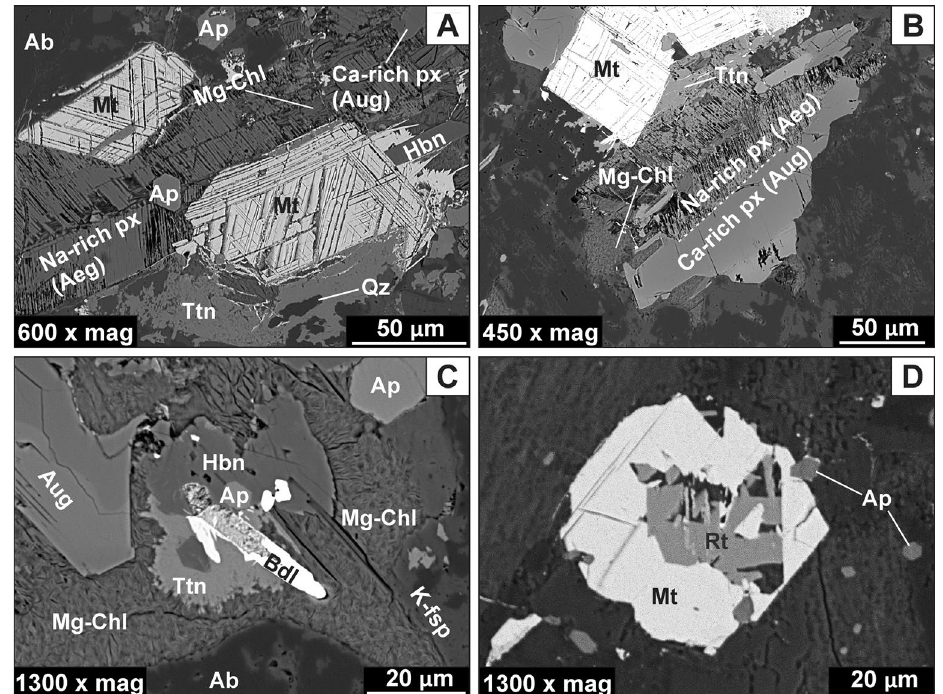
Figure 4. SEM-BSE images of Głuszyca trachyandesites collected from lower parts of the laccolith and showing the presence of unaltered mafic phases such as pyroxene-group species and Ti–rich magnetite. ( A ) Na-rich pyroxene (aegirine) accompanied by Ti–rich magnetite (Mt) consisting oriented thin (trellis-type) intergrowths of ilmenite lamellae. Note the presence of hornblende (Hbn), apatite (Ap), as well as secondary titanite (Ttn) and quartz (Qz); ( B ) Chloritized Na-rich pyroxene (aegirine) enveloped by relatively fresh Ca-rich pyroxene (augite); Note the sharp boundary between those phases, as well as the formation of etched cleavage planes within host Na-rich pyroxene. ( C ) Partial alteration of augite into fibrous Mg-rich chlorite (Mg-Chl); Note the presence of minor hornblende (Hbn), baddeleyite (ZrO 2 ; Bdl), and apatite (Ap). ( D ) Alteration of primary Ti– rich magnetite (Mt) into secondary rutile (or